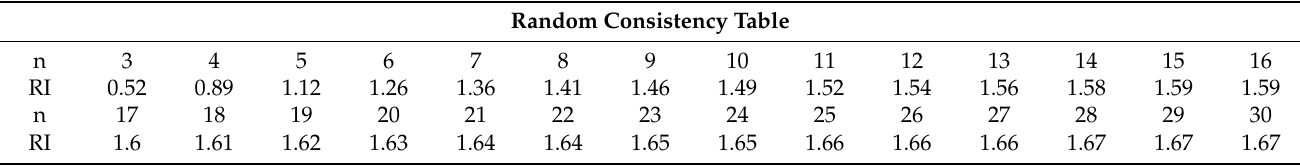
Table 5. Random consistency check form. Random Consistency Table